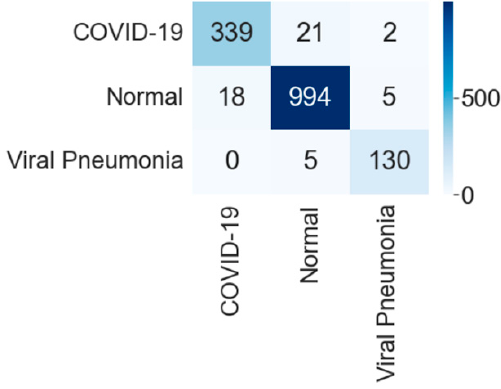
Figure 18. Confusion matrix for three-class classification by VGG16.